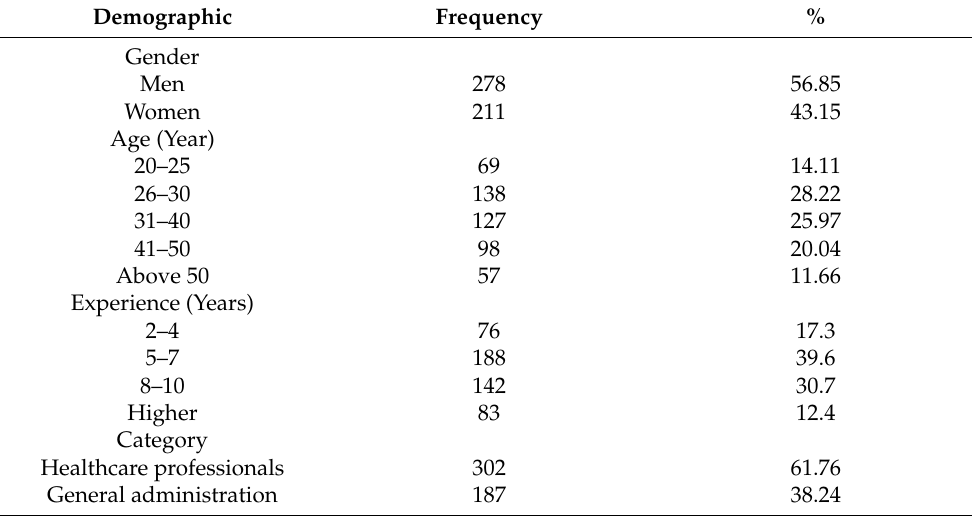
Table 1. Demographic information of the